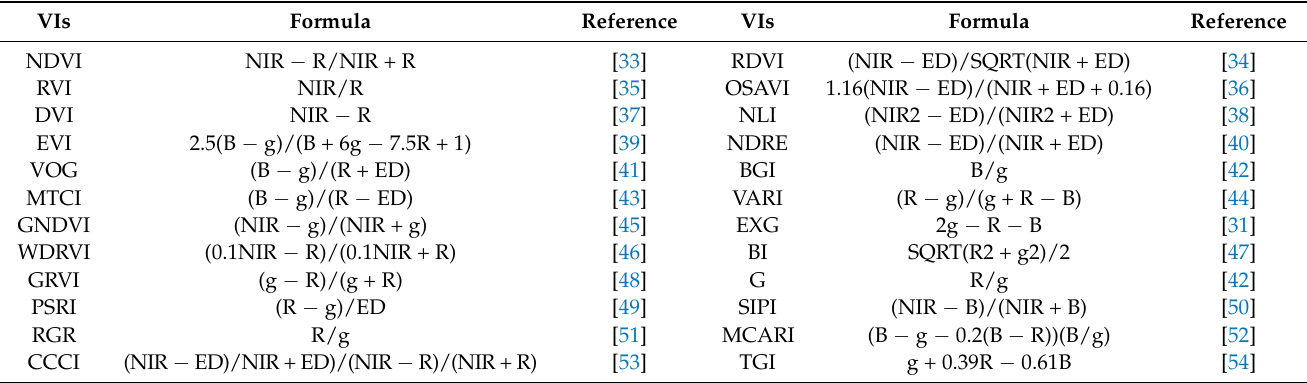
Table 2. Vegetation indices compiled from the